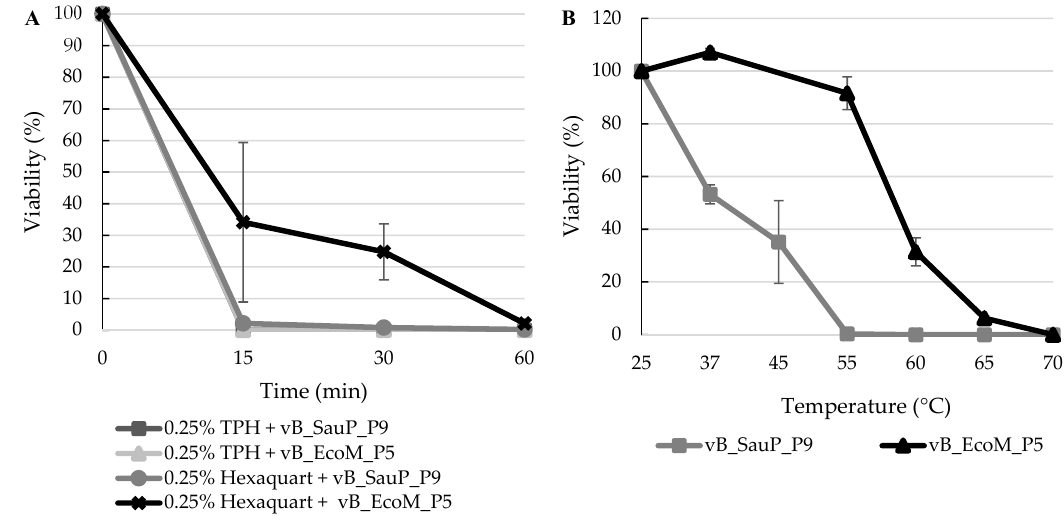
Figure 4. Stability of phages vB_EcoM_P5 and vB_SauS_P9 in the presence of disinfectants ( A ) and increasing temperatures ( B ).